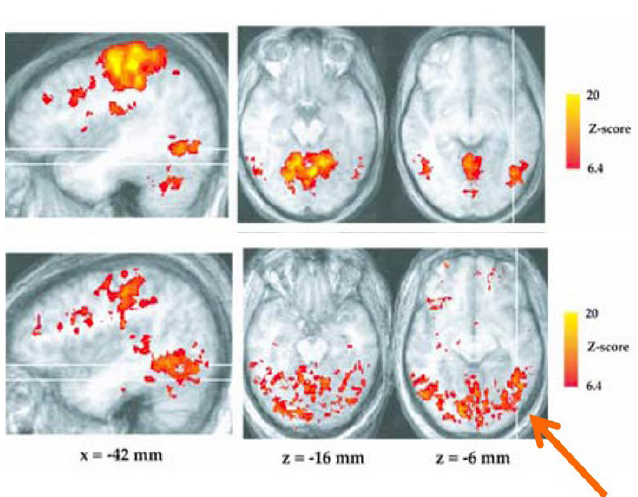
Fig. 2 The figure shows the areas of the ventral-temporal cortex activated in response to tactile perception in visually impaired (above) and blind subjects from birth (below). The arrow indicates the areas of the “visual” ventral-temporal cortex activated by the tactile perception in the blind subjects from birth (from Pietrini et al., PNAS, 2004,